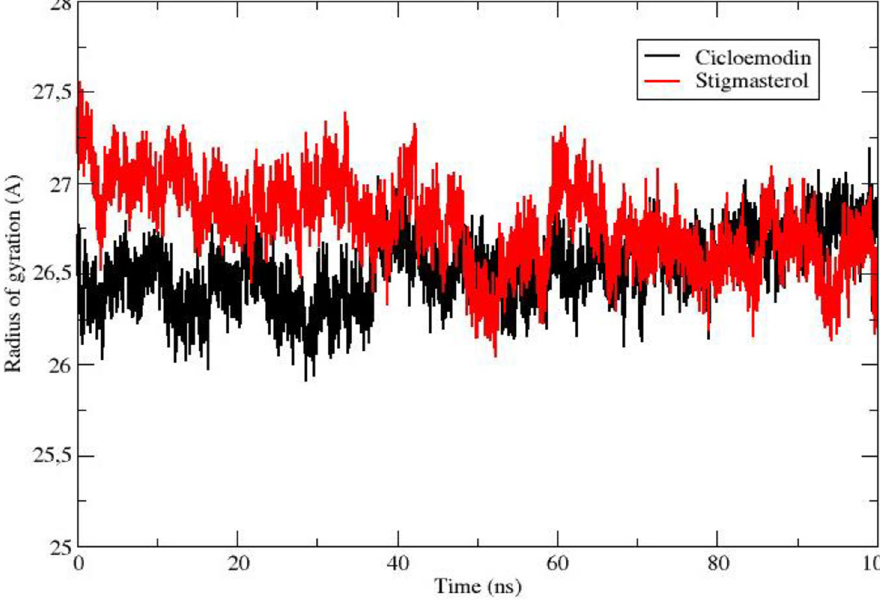
Fig 6. Radius of gyration of active phytoconstituents in complex with 1R9W: Black color is indicating clicoemodin and red color indicates stigmasterol.